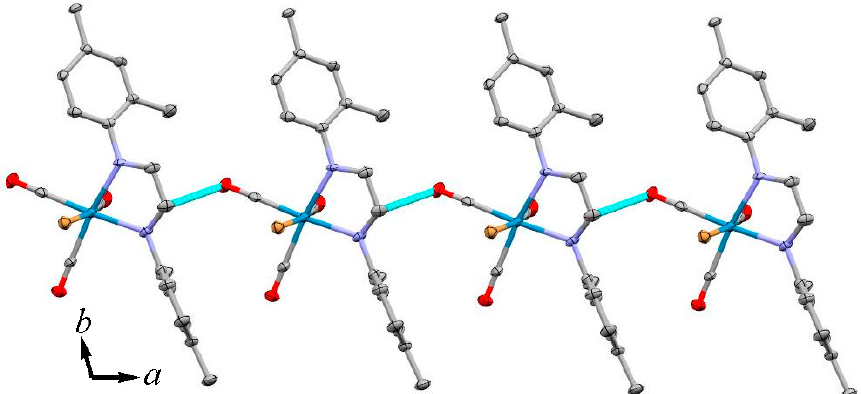
Figure 2. Part of the crystal packing of 1, showing one-dimensional extended chain formation along the a -axis through intermolecular n → π * interaction (H atoms omitted for clarity).